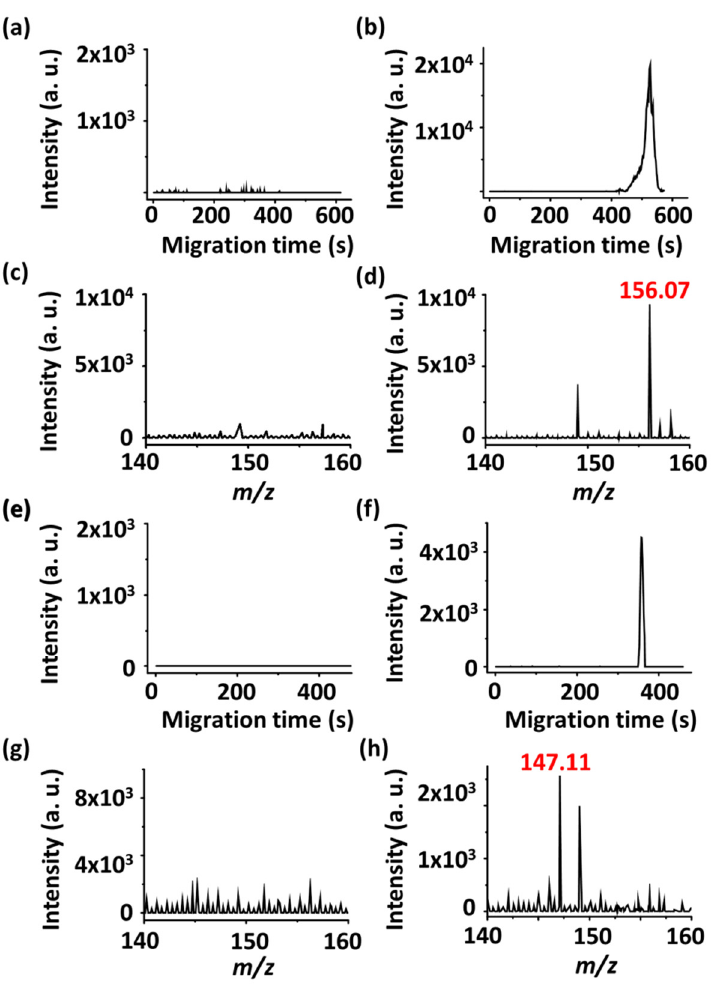
Figure 2. Coupling on-capillary preconcentration with C-API-MS analysis. A tapered capillary (length: ~6.8 cml; OD: ~14 µ m) was used as the interface. Extracted ion chromatogram (EIC) at m / z 156.07 (histidine (5 nM), [M+H] + ) obtained from ( a ) direct C-API-MS analysis and ( b ) after on-line preconcentration followed by C-API-MS analysis. ( c , d ) The corresponding mass spectra. EIC at m / z 147.11 (lysine (25 nM), [M+H] + ) obtained from ( e ) direct C-API-MS analysis and ( f ) after on-line preconcentration followed by C-API-MS analysis. ( g , h ) The corresponding mass spectra. Mass tolerance was set to ± 0.01 amu.